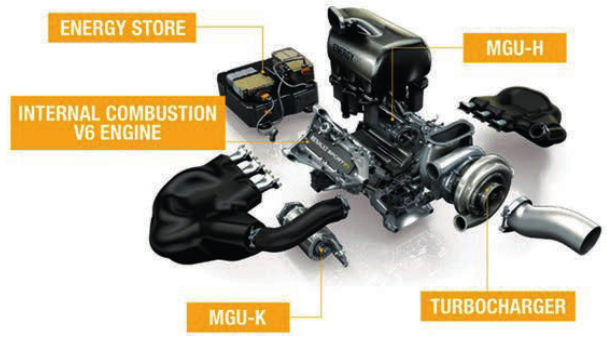
Fig. 1: F1 KERS (ES +MGU-K) and E-BOOST/WHRS (ES+MGU-H) from [8]. The waste energy recovered by the MGU-H and transferred to turbo-lag device.